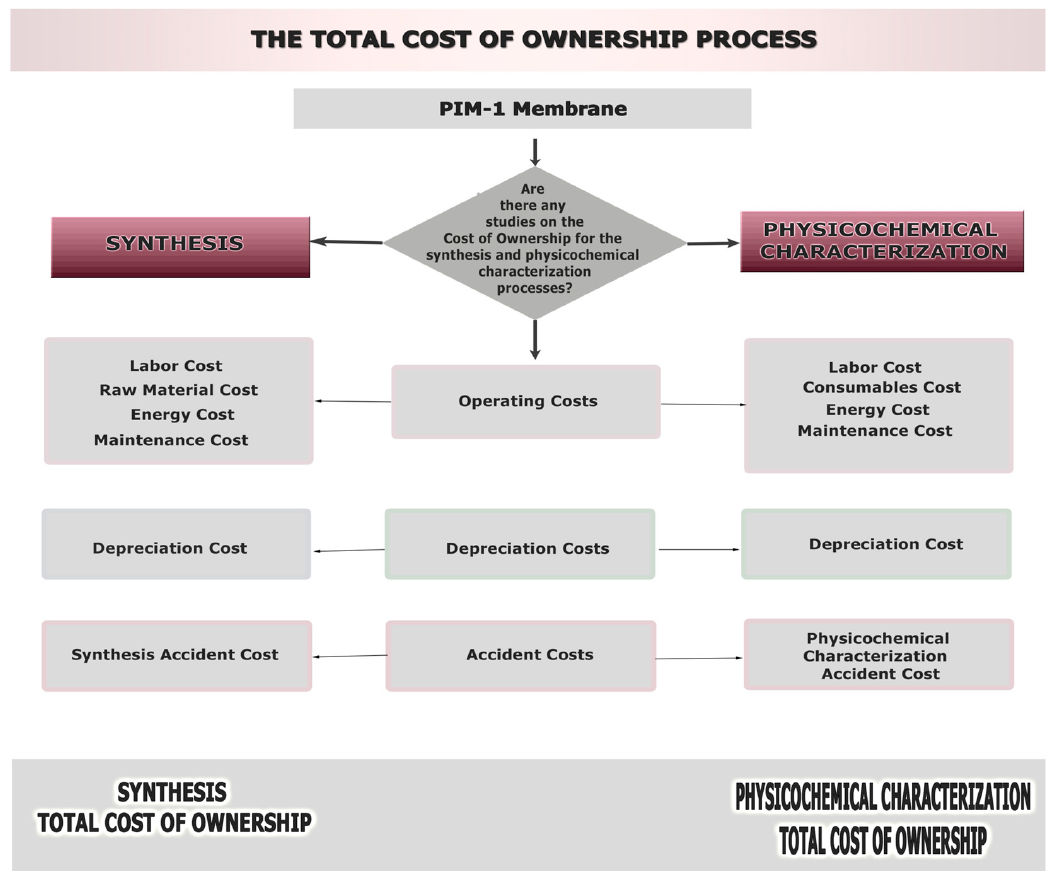
Figure 2. Total cost of ownership process for the synthesis and characterization phases of PIMs.